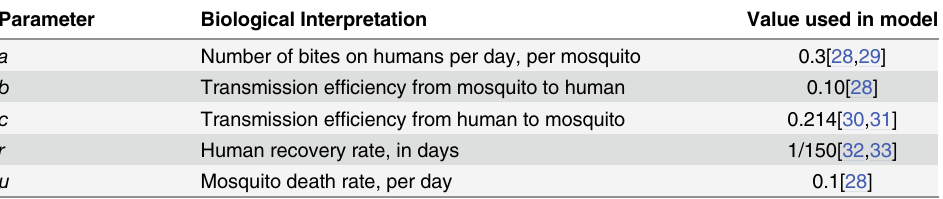
Table 1. Model parameter definitions and values of each parameter used in process validation simulations.